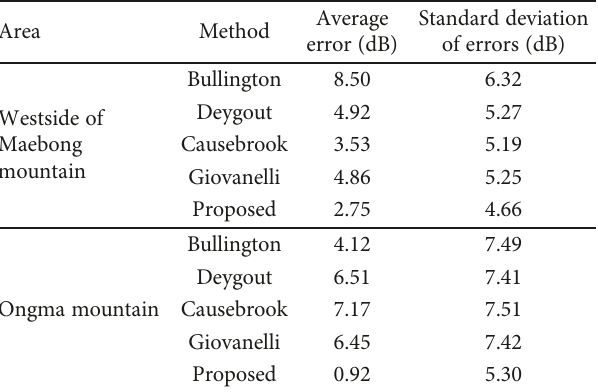
Table 1: Comparison of prediction performance.